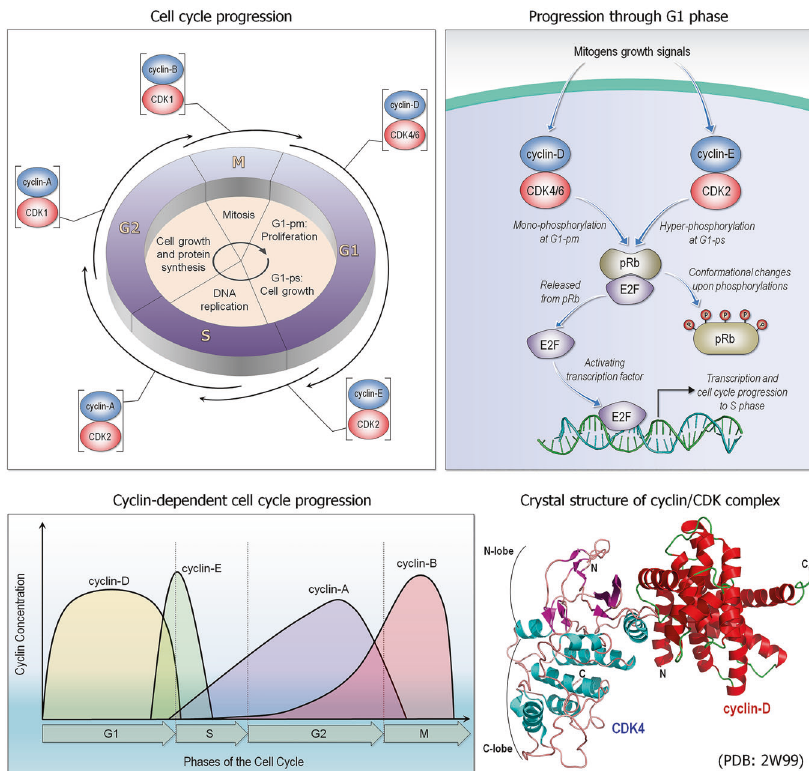
Fig. 2 Cyclin-dependent kinases (CDKs) cell cycle. CDKs and their cyclin partners form complexes, regulating the progression through the cell cycle (upper left panel). In early G1 phase (G1-pm), retinoblastoma protein (pRb) becomes phosphorylated by the complex, a pair of cyclin-D and CDK4/6 (upper right panel). In late G1 phase (G1-ps), pRb is hyper-phosphorylated by cyclin-E/CDK2 complex, undergoing a large conformational change. This conformational change fails to assemble with E2F, a transcription factor, which promotes to progress the G1/S transition. Cyclins bind with the dependent kinases and their concentration varies during the cell cycle (lower left panel). A crystal structure illustrates an example of cyclin/CDK complex (PDB: 2W99) (lower right panel). Apo-CDKs exhibit little kinase activity; CDKs become active kinases when interacting with the regulatory protein called a